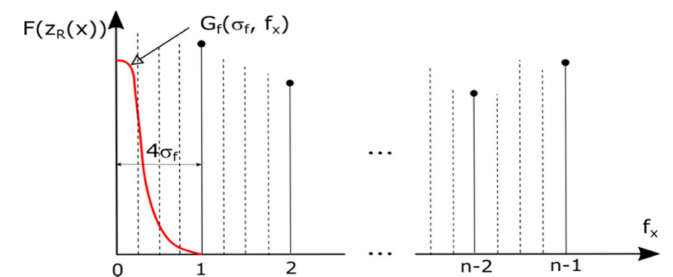
Figure 10. Example map of roughness template No. 178–601 with marked squares showing where the measurement was made.